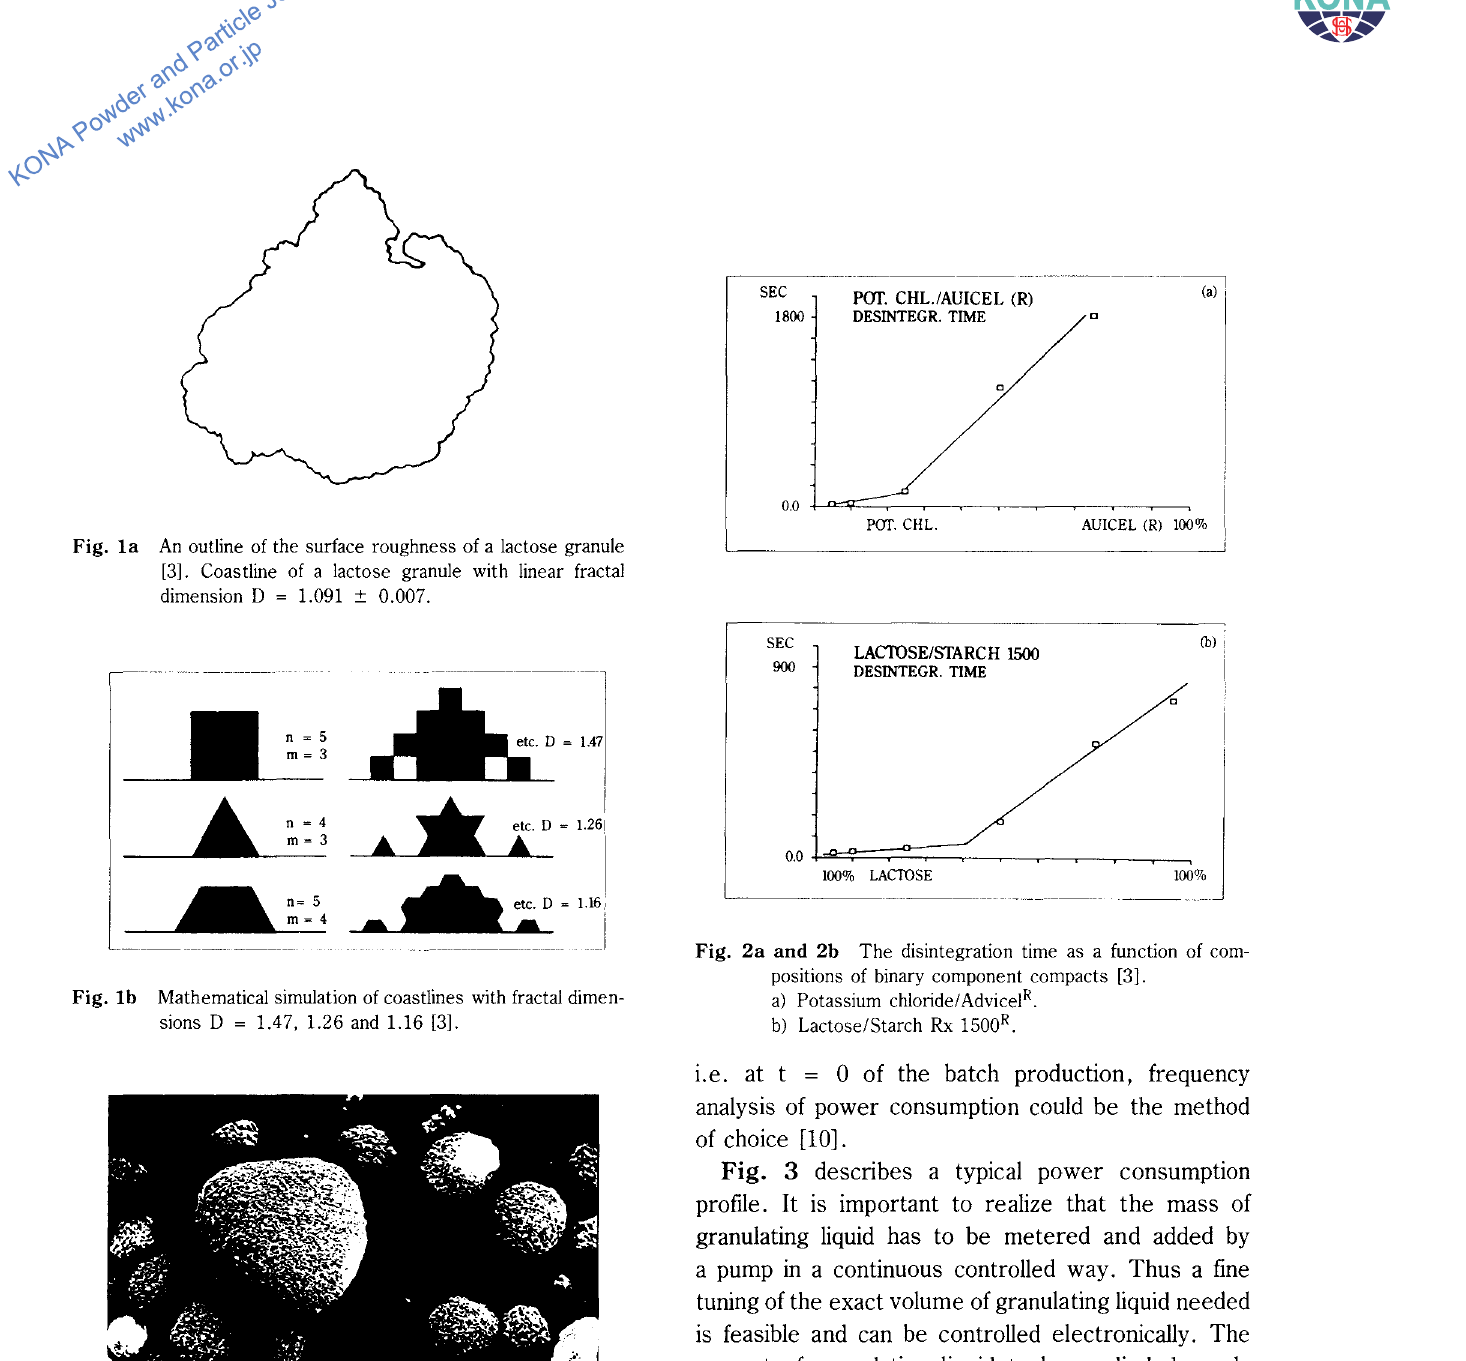
Fig. lc Scanning electron micrograph of the surface of lactose granules [3].